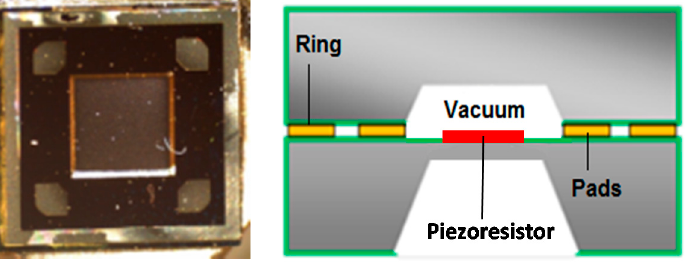
Figure 2. Optical view of upper silicon die on the ( left ) and crosssectional drawing on the ( right ) for hermeticity test